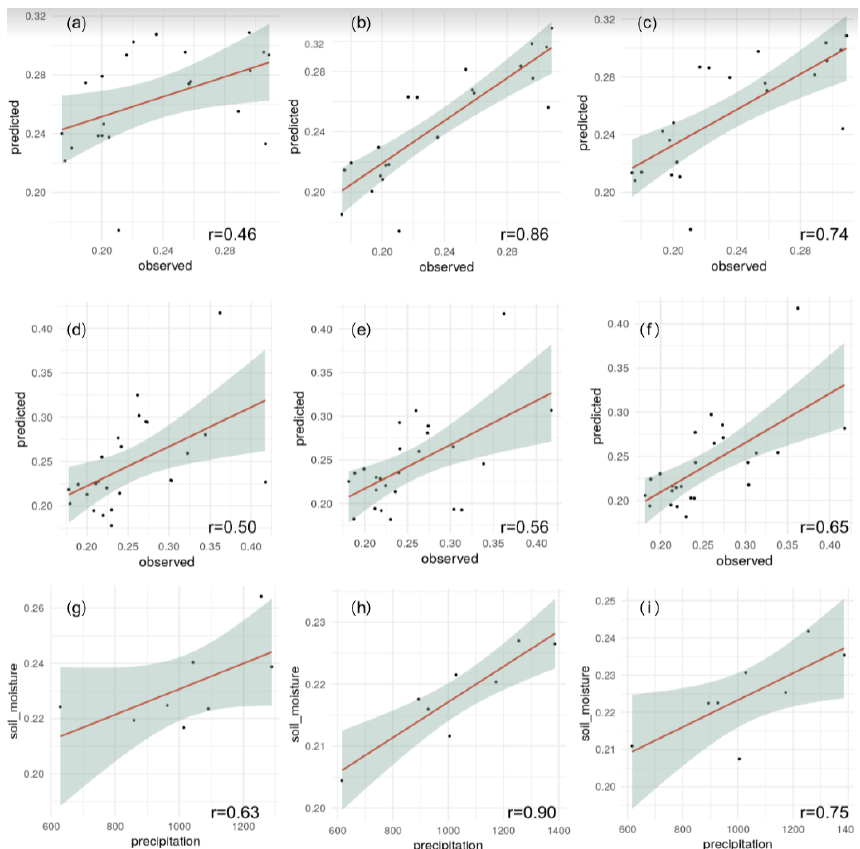
Figure 8. Model evaluation plots (points vs. grids) of mean annual values of soil moisture across the world. ISMN against the ESA-CCI (a) , ISMN against the predictions based on terrain analysis (b) , and ISMN against the predictions based on the model using bioclimatic and soil type classes (c) for the sites with available information between 0–5cm ( n = 987 stations). We also show the correlation between the ESA- CCI (d) and our predictions based on terrain parameters (e) or bioclimatic and soil type classes (f) using all available data in the ISMN across all soil depths ( n = 2185 stations). The panels below show the correlation between soil moisture grids and in situ mean annual precipitation records and in situ precipitation against the ESA-CCI (g) , in situ precipitation against predictions based on terrain analysis (h) , and in situ precipitation against predictions based on the model using bioclimatic and soil type classes (i)